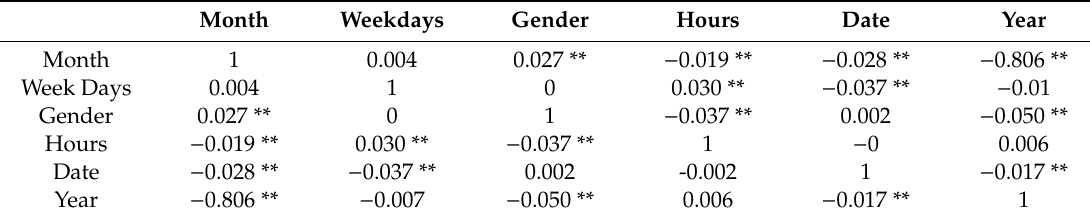
Table 3. Correlation matrix.